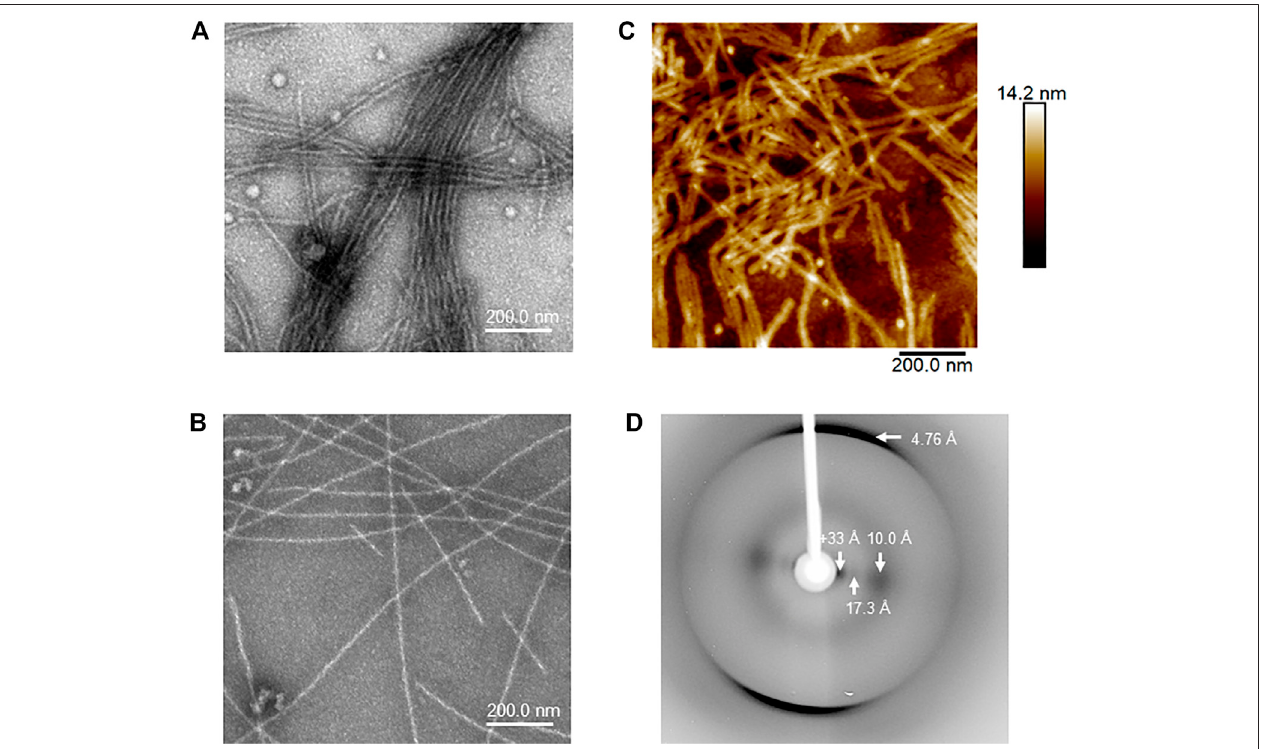
FIGURE 5 | Structural and morphologic analysis of Tau35 aggregates. Electron micrographs of heparin-induced aggregates Tau35 (A) and 2N4R tau (B) incubatedfor72 hat37 ° C. (C) SimilarmorphologyofTau35aggregateswasobservedbyAFM. (D) X-ray fi ber diffraction ofalignedTau35 fi bersindicatingthepresence of a typical cross- β structure.